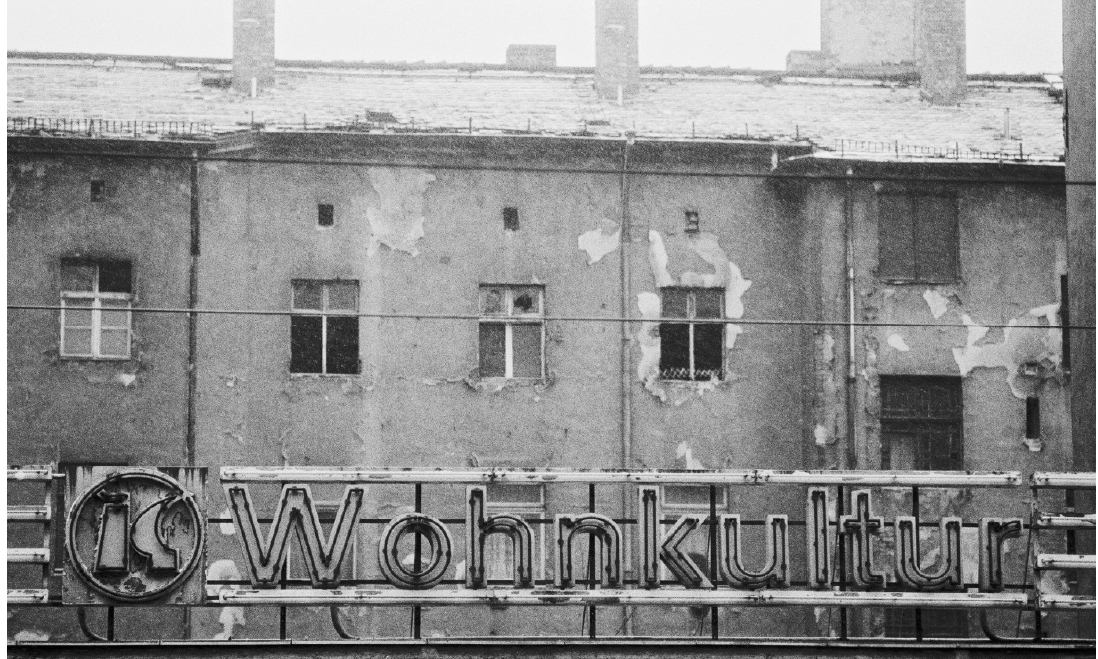
Figure 6. Harald Hauswald, Dimitroffstraße, Schönhauser Allee, Berlin-Prenzlauer Berg , (Dimitroffstraße, Schönhauser Allee, Berlin-Prenzlauer Berg), 1985. Photo Credits: Ostkreuz–Agentur der Fotografen/Harald Hauswald.